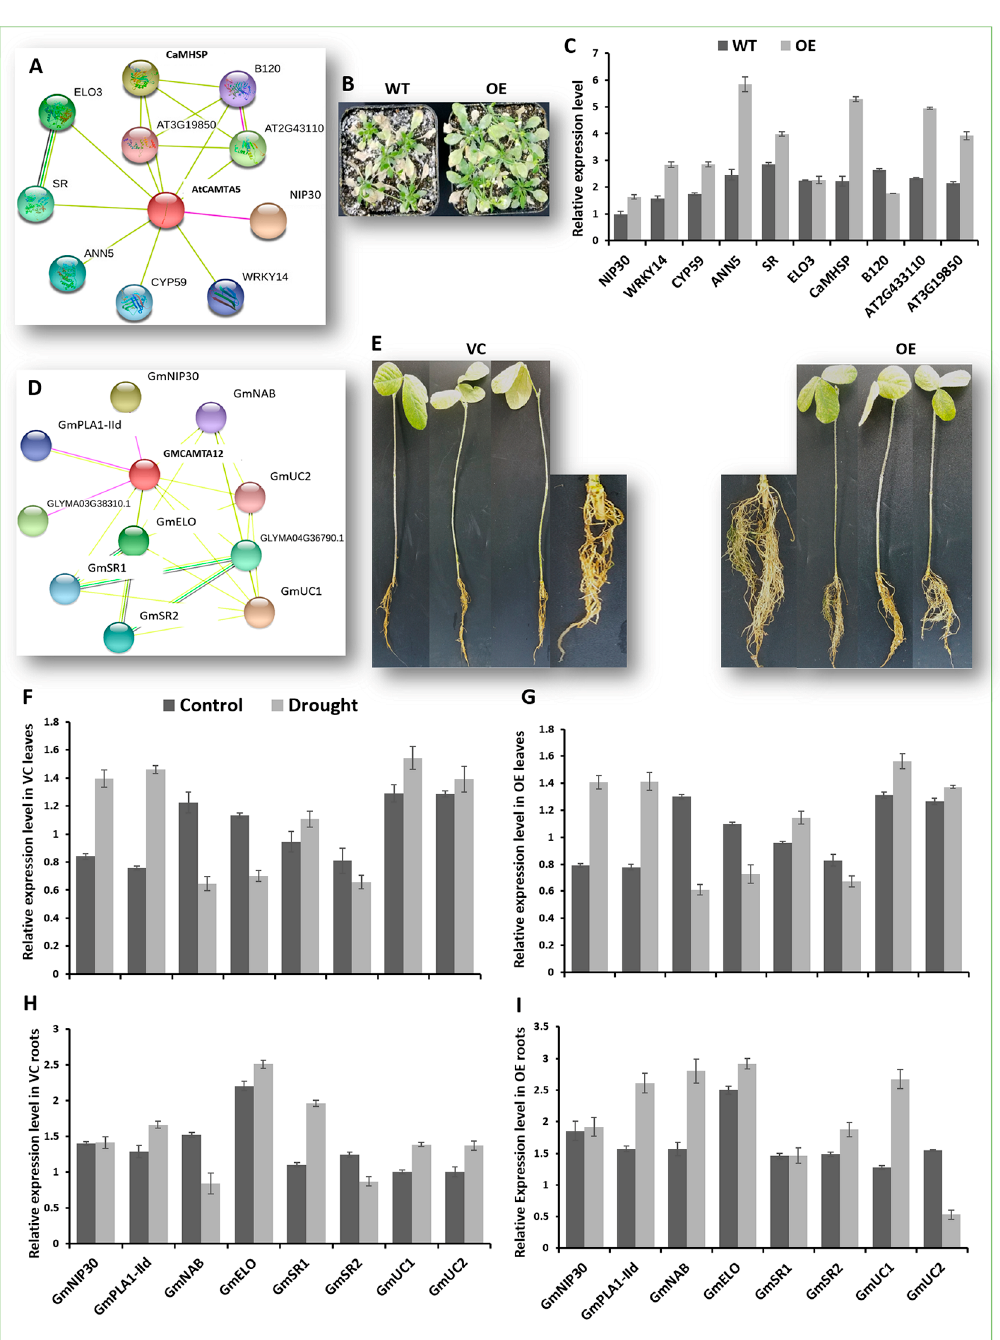
Figure 7. Expression analysis of genes in the regulatory network of GmCAMTA12 and AtCAMTA5 . ( A ) STRING-predicted regulatory network of AtCAMTA5 . ( B ) Drought treated WT and OE Arabidopsis. ( C ) Expression profile of the 10 interactors of AtCAMTA5 in WT and OE Arabidopsis. ( D ) STRING-predicted regulatory network of GmCAMTA12 in soybean. ( E ) Chimeric soybean plants with VC and OE hairy roots. ( F ) Expression analysis of the eight interactors of GmCAMTA12 in VC and ( G ) OE leaves. ( H ) Expression analysis of the eight interactors in VC and ( I ) OE